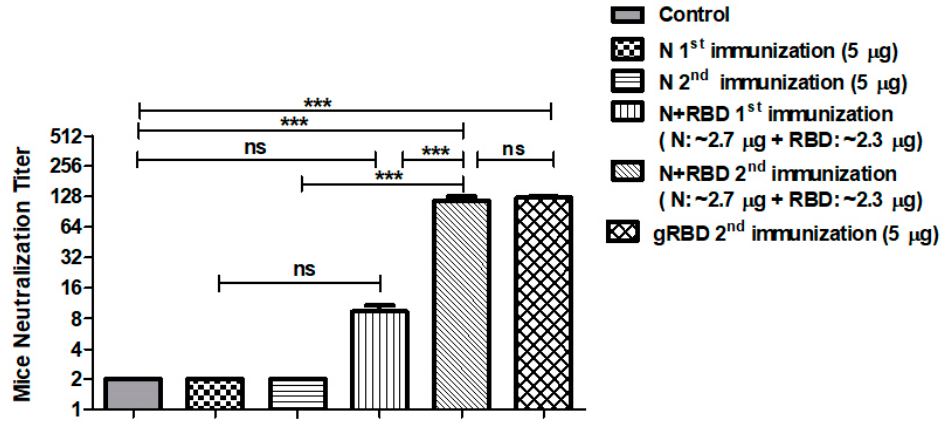
Figure 6. In vitro microneutralization assay of mouse sera against live SARS-CoV-2 in the Vero E6 cell line immunized with plant-produced RBD [4], N, or N+RBD proteins. In vitro microneutralization assay of 21st and 42nd day mouse sera immunized with plant-produced RBD [4] and N+RBD (~2.7 µ g + 2.3 µ g, respectively) against live SARS-CoV-2 in the Vero E6 cell line as indicated. gRBD 2nd immunization (5 µ g): in vitro microneutralization of sera from mice immunized with 5 µ g of gRBD on day 42 [4]. The experiment was performed using 32 to 1024 dilutions of mouse sera collected on day 21 and day 42. One-way ANOVA Tukey’s multiple comparison tests were used to calculate statistical significance ( n = 6 mice/group); *** p < 0.001.